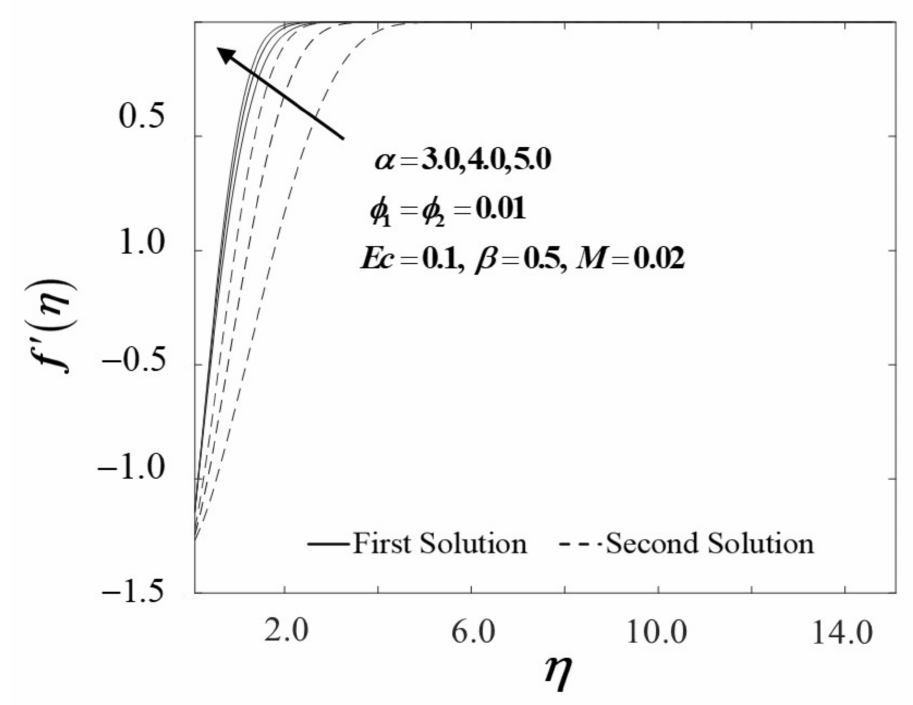
Figure 10. f (cid:48) ( η ) versus η with specific α .